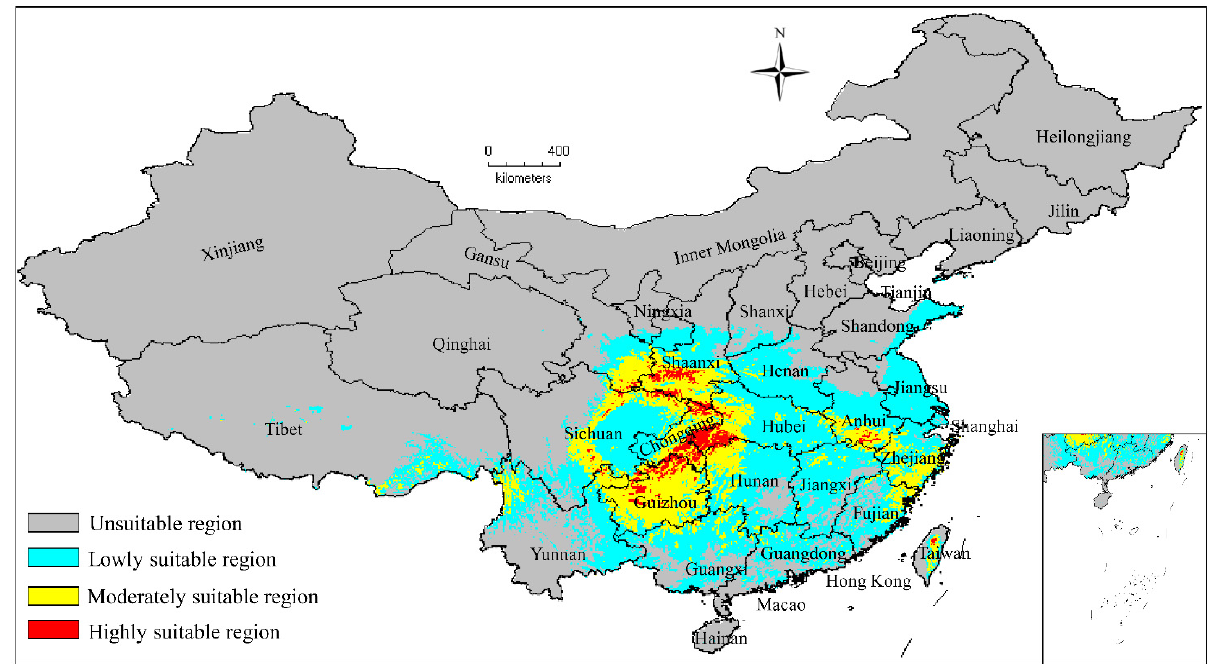
Figure 2. Predicted distribution of C. appendiculata in China under current climate conditions.